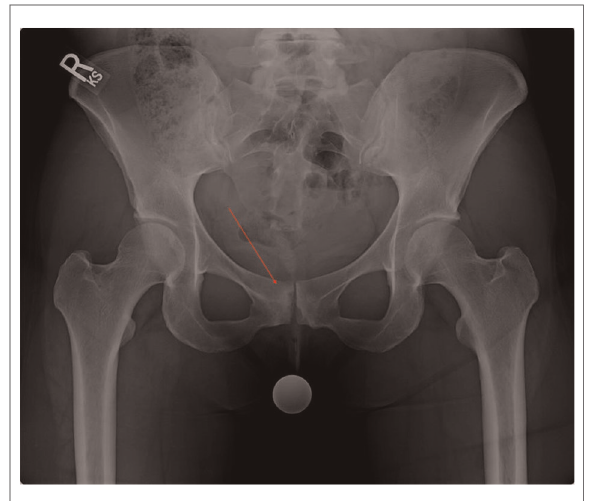
FIGURE 2 Anteroposterior radiographic image of a pelvis demonstrating bone edema (red arrow) and sclerotic changes in the pubic symphysis consistent with osteitis